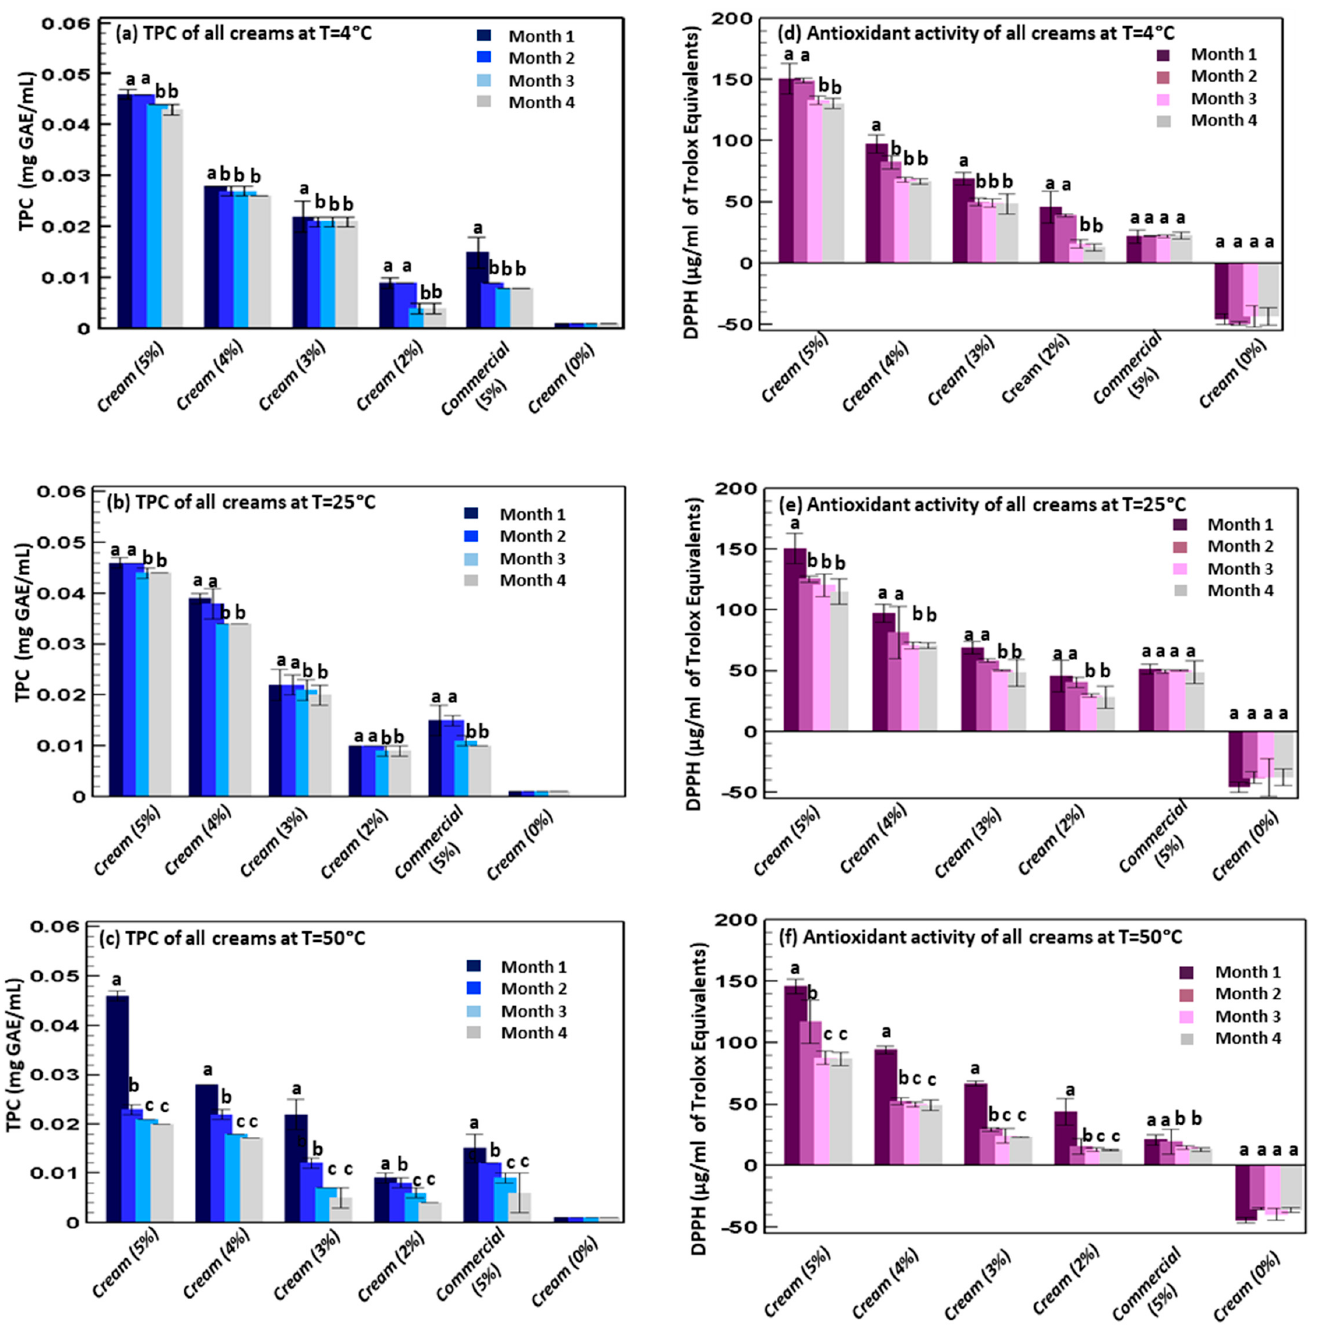
Figure 7. Total Phenolic Content (TPC) measured at 4 °C ( a ), 25 °C ( b ) and 50 °C ( c ) and antioxidant activity (DPPH assay) measured at 4 °C ( d ), 25 °C ( e ) and 50 °C ( f ) of the creams containing 0, 2, 3, 4, 5% of Marselan hydro-glyceric extract, or 5% of the commercial extract. Mean values ± standard deviations were reported. Each letter indicates the same value ( p > 0.05).